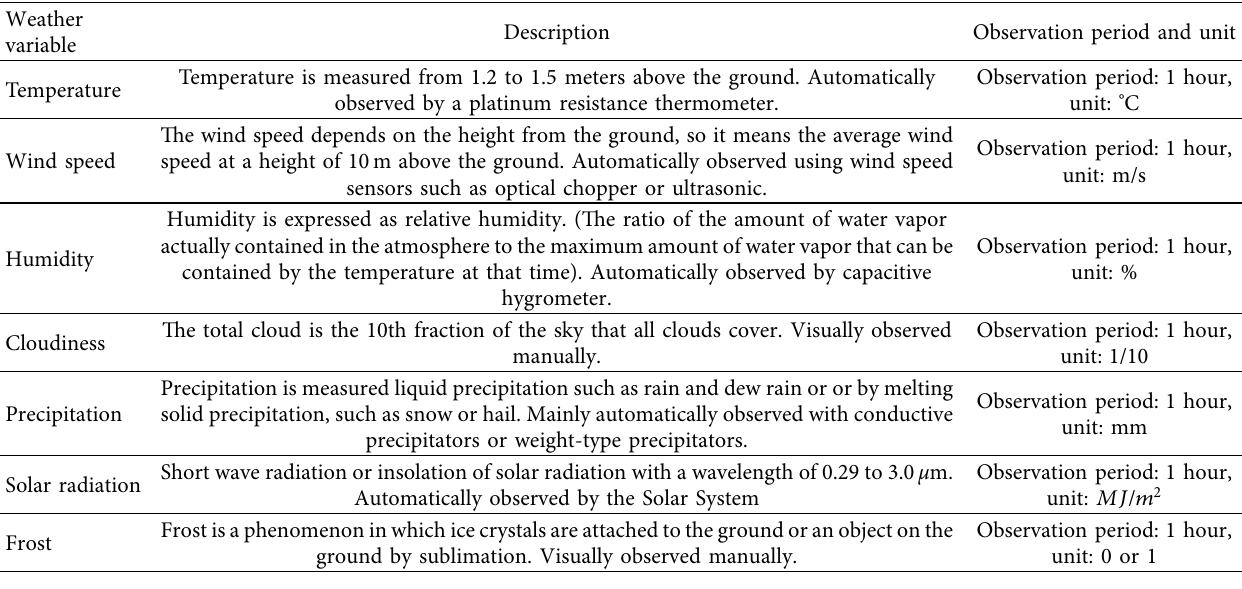
Table 1: Description of weather variables.